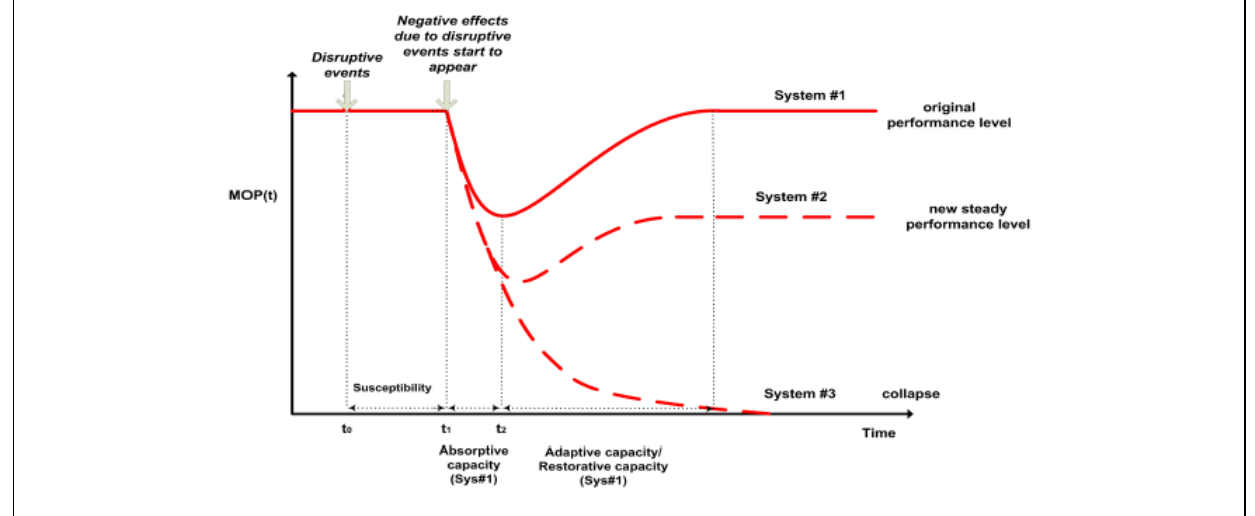
Fig. 1. Main regularities of robust and non-robust behavior of the system